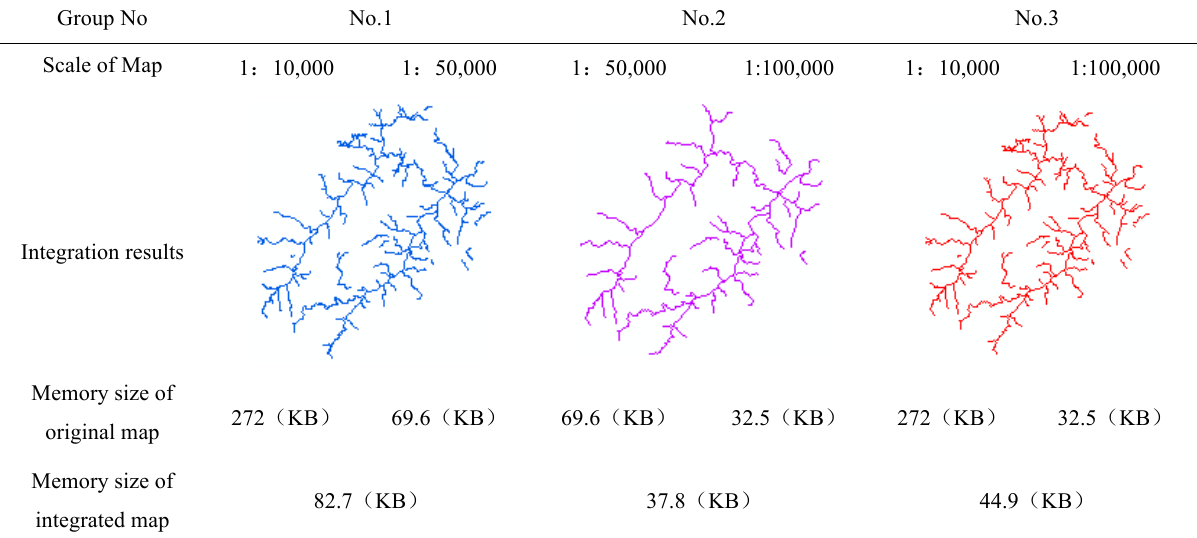
Table 1: The results of three groups of